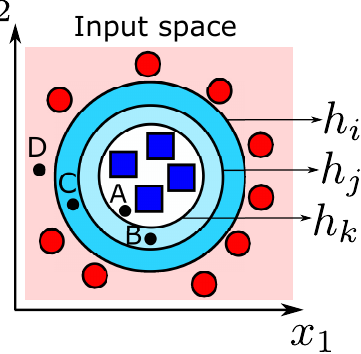
Figure 7. An illustrative example for explaining the version space. h i , h j , and h k are consistent with D L (the colored points), where h i is the most general hypothesis and h k is the most specific one. The points (A and D) are certain (i.e., all hypotheses agree on them), whereas the points B and C are uncertain with different uncertainty levels (e.g., h k classifies B to the red class, whereas h i classifies B to the blue